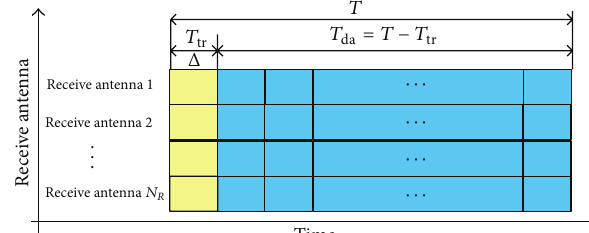
Figure 3: A channel estimation example for RCRAS